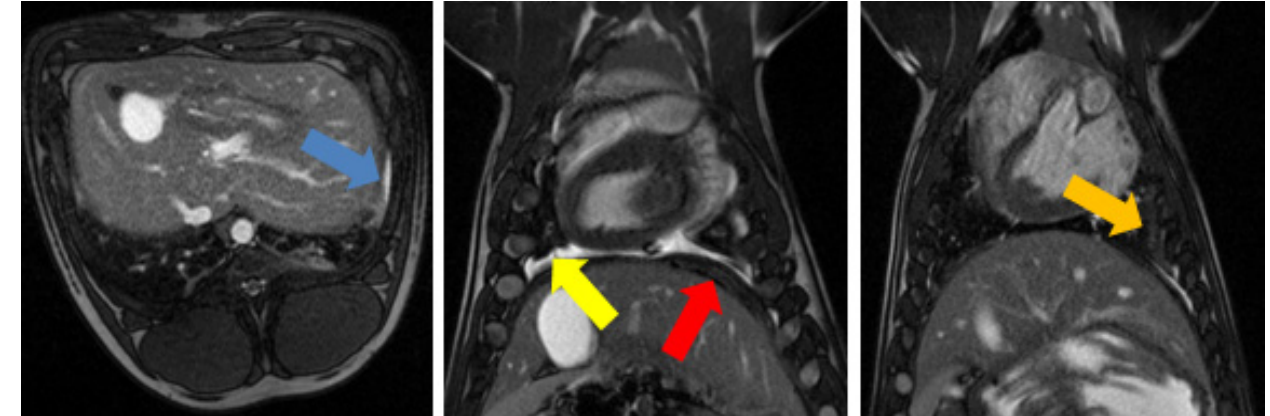
Figure 3. Main mesothelioma findings in MRI. ( Left ): True fast imaging with steady state precession (FISP) transverse image of pig #8 showing pleural thickening (blue arrow); ( Middle ): True FISP coronal image of pig #8 showing pleural fluid (yellow arrow) and the increased thickness of diaphragm (red arrow); ( Right ): True FISP coronal image of pig #8 showing adhesions (orange arrow).